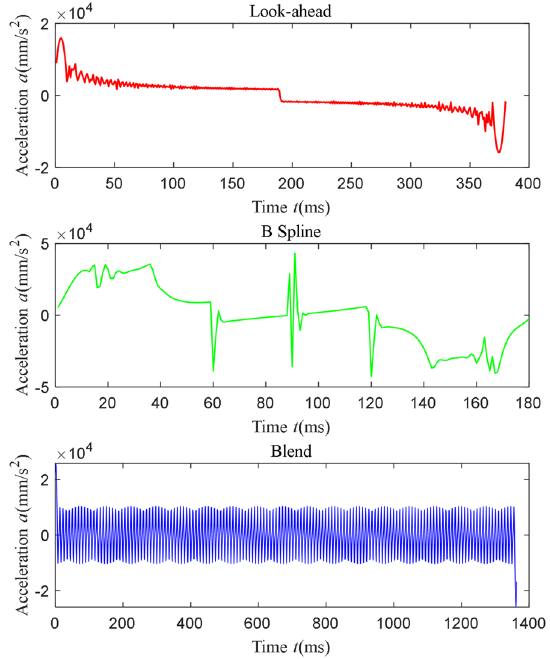
Figure 7 Comparison of acceleration values for the three methods